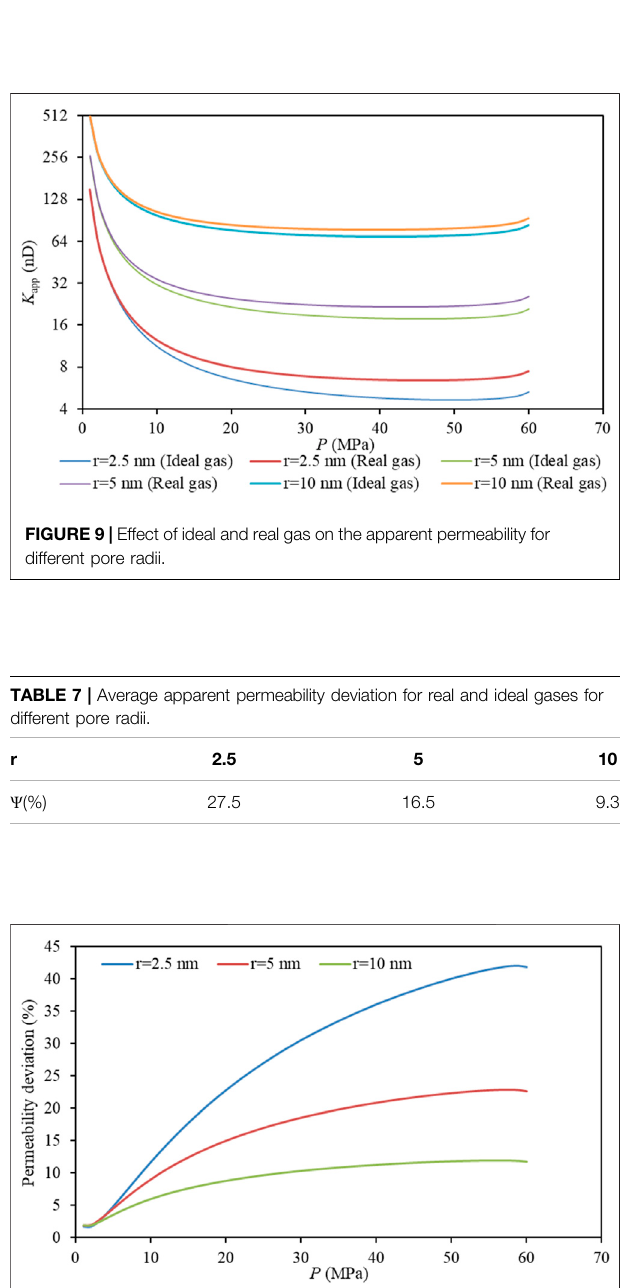
FIGURE10 | Apparent permeability deviation for realand ideal gases for different pore